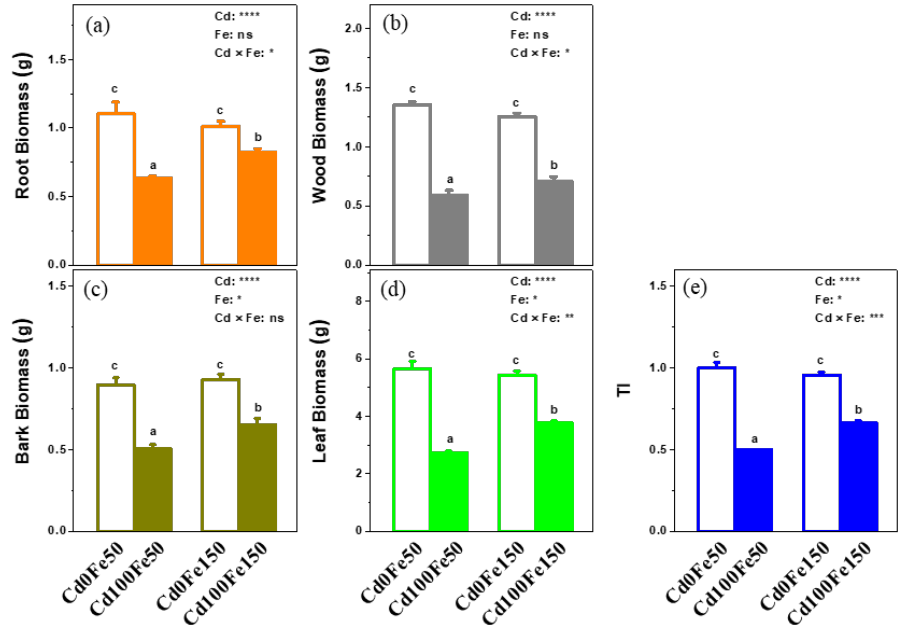
Figure 2. The biomass of root ( a ), wood ( b ), bark ( c ), leaves ( d ), and TI © of poplar under different Cd and Fe combined treatments. Data were means ± SE (n = 6). Different lowercase letters on the bars indicate significant differences in ANOVA ( p < 0.05). p values of two-way ANOVA on Cd, Fe, and their interaction (Cd × Fe) were indicated (*, p < 0.05; **, p < 0.01; ***, p < 0.001; ****, p < 0.0001; ns, not significant). The same below.